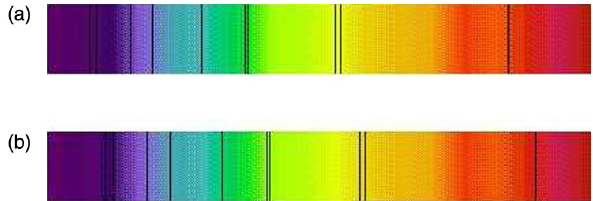
FIG. 5. Spectra: Red-shift. Following open-ended question was asked: (a) is the spectrum that was obtained looking at a nearby galaxy. (b) is the spectrum that was obtained from a distant galaxy. What explains the difference between spectrum (a) and spectrum